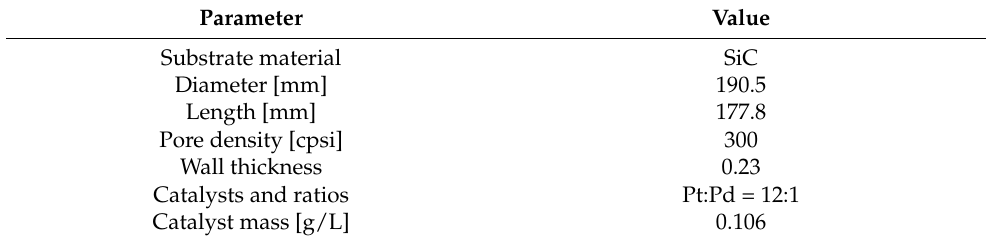
Table 2. The main specifications of the